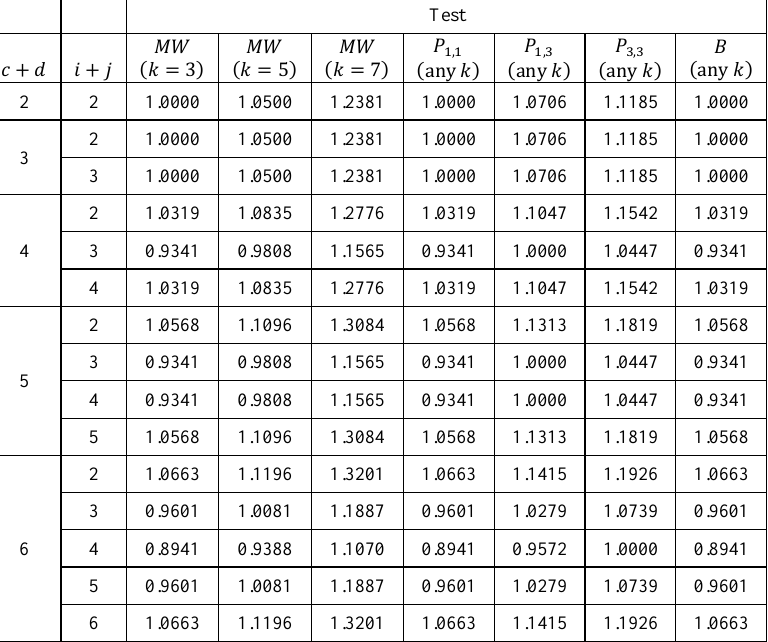
Table 7. AREs of 𝑇 for Gumbel distribution w.r.t. different 𝑐,𝑑;𝑖,𝑗